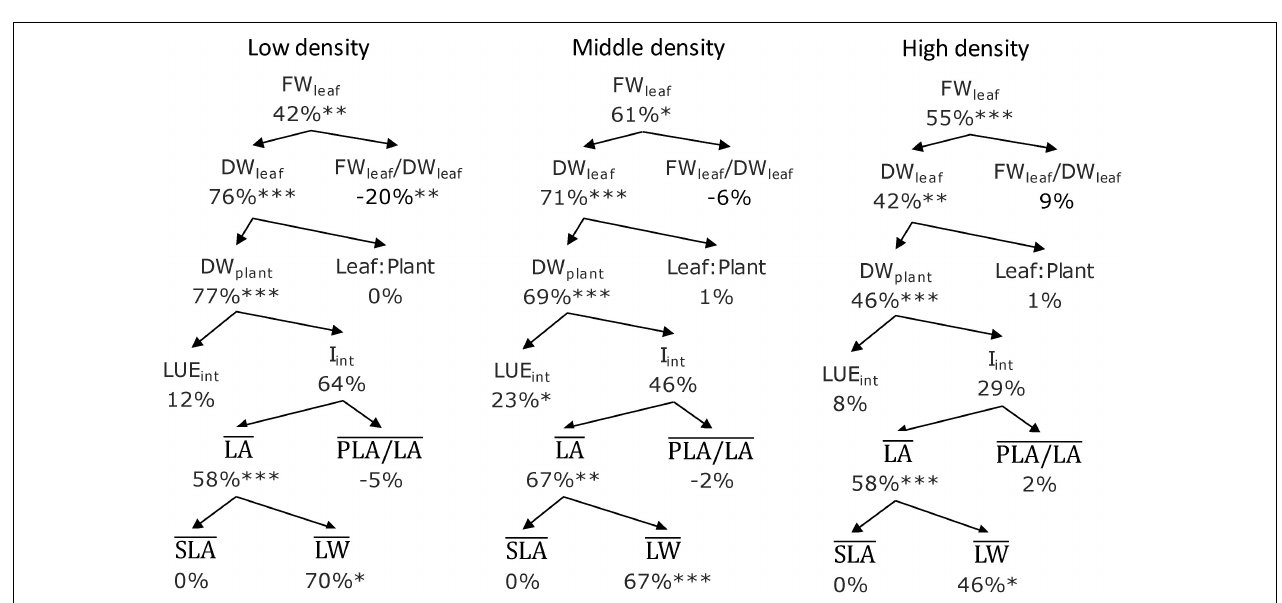
FIGURE 8 | Effect of adding far-red radiation (FR) on top of red and blue at three planting densities. Percentages are the RB + FR increment on top of RB. Abbreviations within schemes are as follows: FW leaf , leaf fresh weight; DW leaf , leaf dry weight; FW leaf /DW leaf , leaf fresh/dry weight ratio; DW plant , plant total dry weight; Leaf:Plant, ratio of leaf dry weight in total plant; LUE int , intercepted light use efficiency; I int , canopy-intercepted photosynthetic photon flux density; LA, plant leaf area; PLA / LA, projected leaf area and leaf area ratio; SLA, specific leaf area; LW, leaf weight. The LA, PLA / LA, SLA, and LW are all averaged values over 14, 21, and 28 days after transplanting (DAT) representing cumulative values during the whole cultivating period (0–28 DAT). ∗ P < 0.10, ∗∗ P < 0.05, and ∗∗∗ P < 0.01. Data are means of two ( n = 2) or three blocks ( n = 3) each with four–six replicate plants.